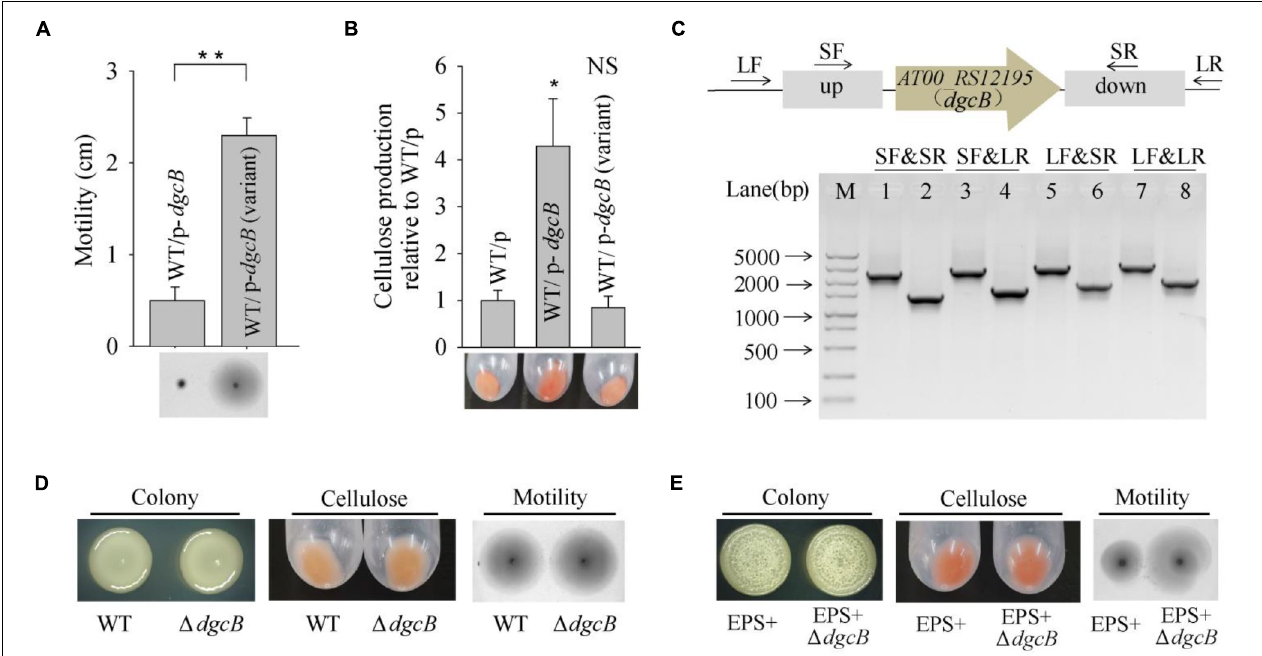
FIGURE 4 | The V4 wrinkled variant harbors a dgcB mutation that increases swimming motility. (A) Swimming motility of the wild-type strain expressing DgcB from the wild-type and V4 variant strains. (B) Cellulose production by the wild-type strain expressing DgcB from the wild-type and V4 variant strains. (C) In-frame deletion of dgcB in P. lipolytica wild-type strain was confirmed by PCR using four primer sets flanking the open reading frame of dgcB (up panel). M indicated marker. Lanes 1, 3, 5 and 7 used DNA from the wild-type strain, and lanes 2, 4, 6 and 8 used DNA from the dgcB mutant strain. (D) The colony morphology, cellulose production and swimming motility of the wild-type and (cid:49) dgcB mutant strains. (E) The colony morphology, cellulose production and swimming motility of the EPS+ and EPS+ (cid:49) dgcB mutant strains. Statistical significance (* P < 0.05; ** P < 0.01; NS, not significant) is indicated with asterisks.